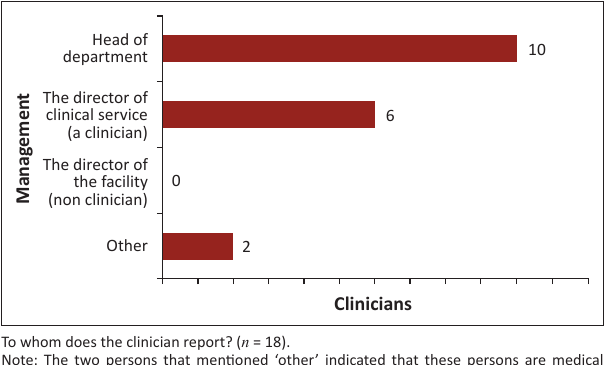
FIGURE 1: Factors related to the management of the organisation, response of